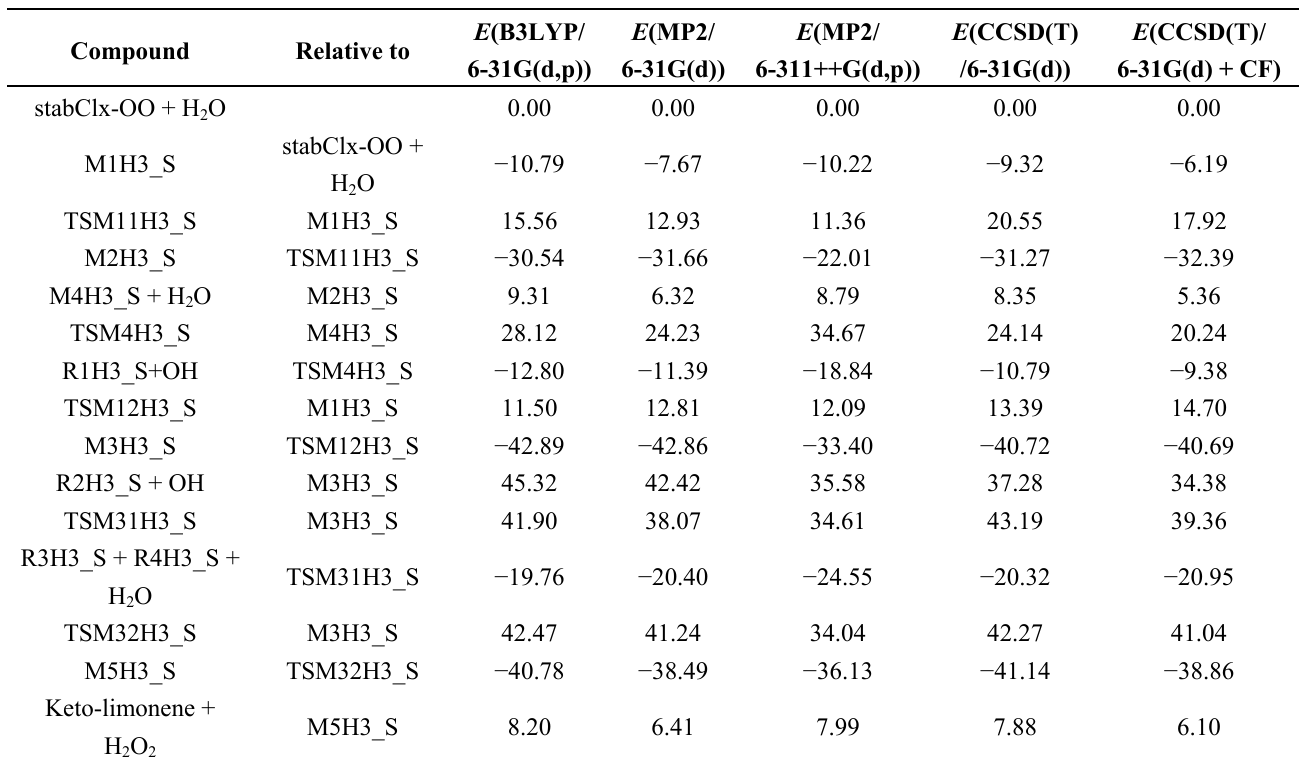
Table 3. Reaction and activation energies ( E ) with Zero-Point Correction (ZPE) included (kcal mol − 1 ) for the reaction between stabCl x -OO and H O a at different levels of theory. 2 E Compound Relative to